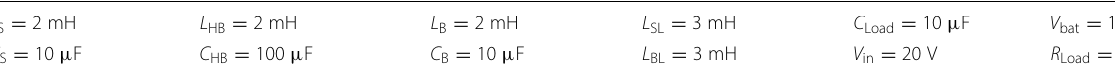
Table 2 The assumed values to define the systems point of operation (2)